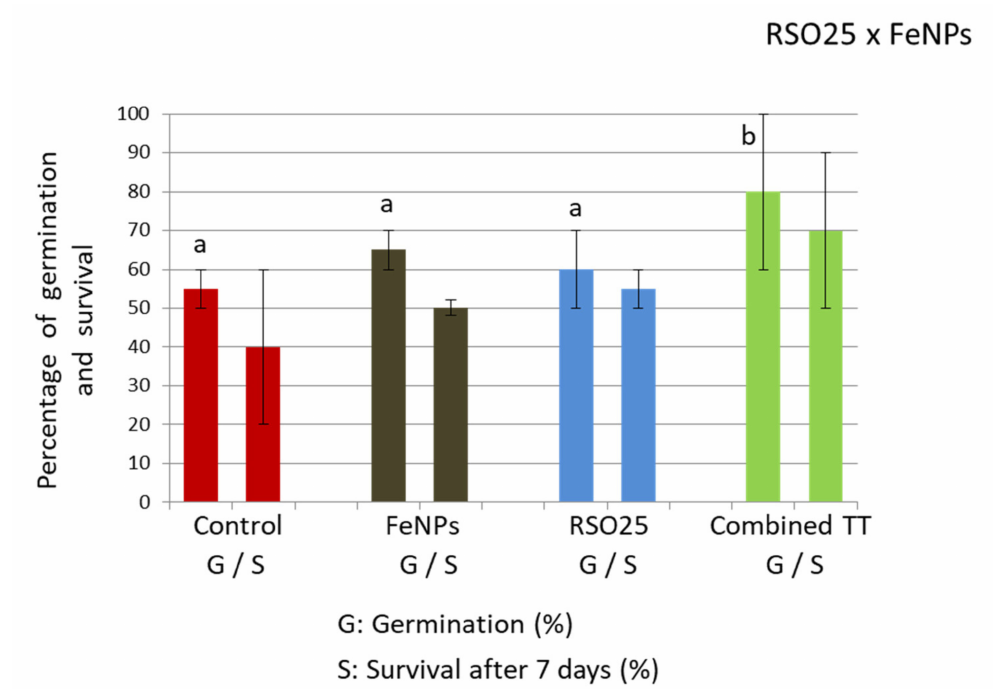
Figure 3. Germination rate (final germination after five days) and survival after seven days of seedlings treated with different biofortification treatments: control; FeNPs treated with Fe-containing nanoparticles; RSO25, inoculated with Bacillus aryabhattai RSO25; TT combined, treatment including FeNPs and Bacillus aryabhattai RSO25. Data are means of 50 seeds ± standard deviations. RSO25, FeNPs or their interactions in the corner of the panel indicate main or interaction significant effects. Different letters indicate means that are significantly different from each other. (LSD test, p <